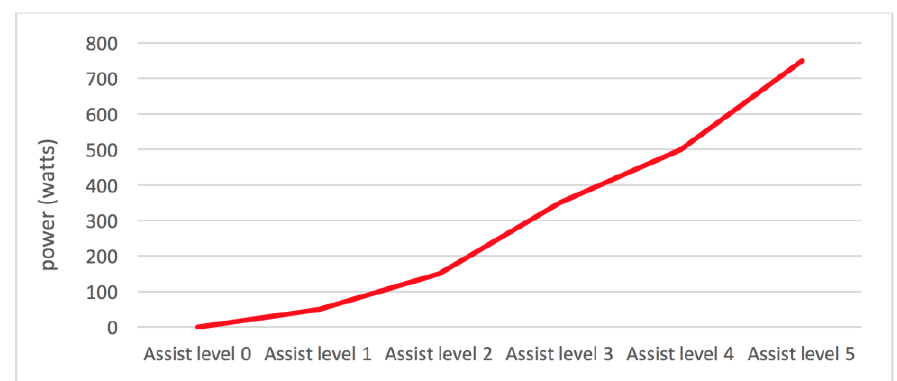
Figure 2. Assist levels and power in an e-bike of 750 w.